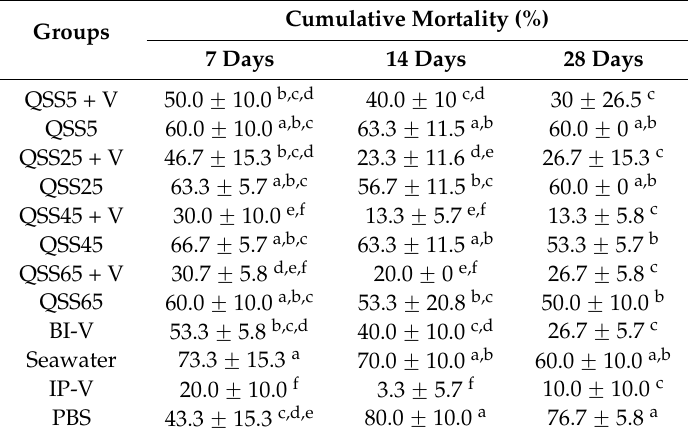
Table 1. Cumulative mortality of turbot challenged with V. anguilarum at days 7, 14 and 28 post-immunization *.